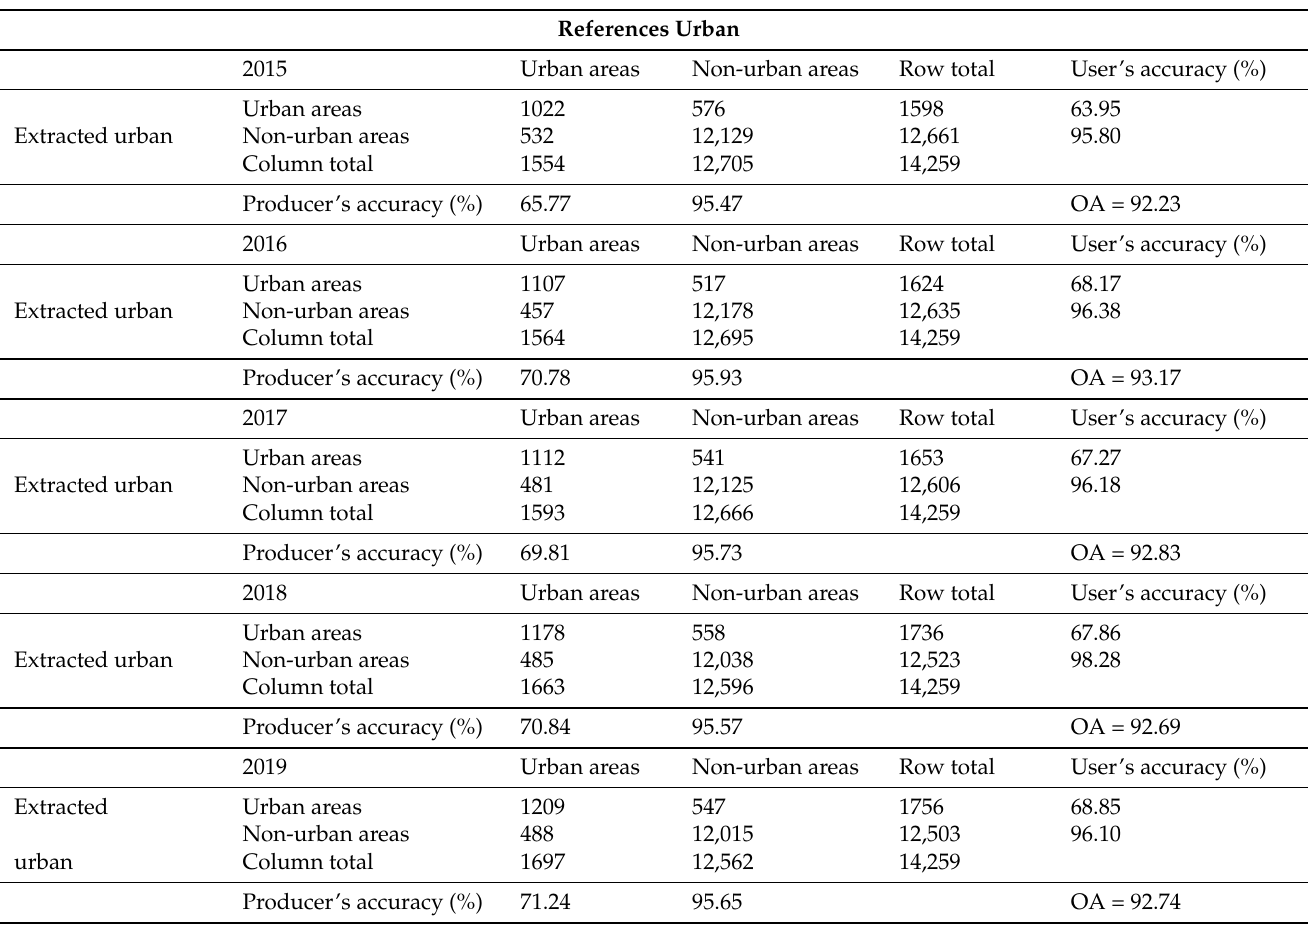
Table 2. The confusion matrix in Chengdu from 2015 to